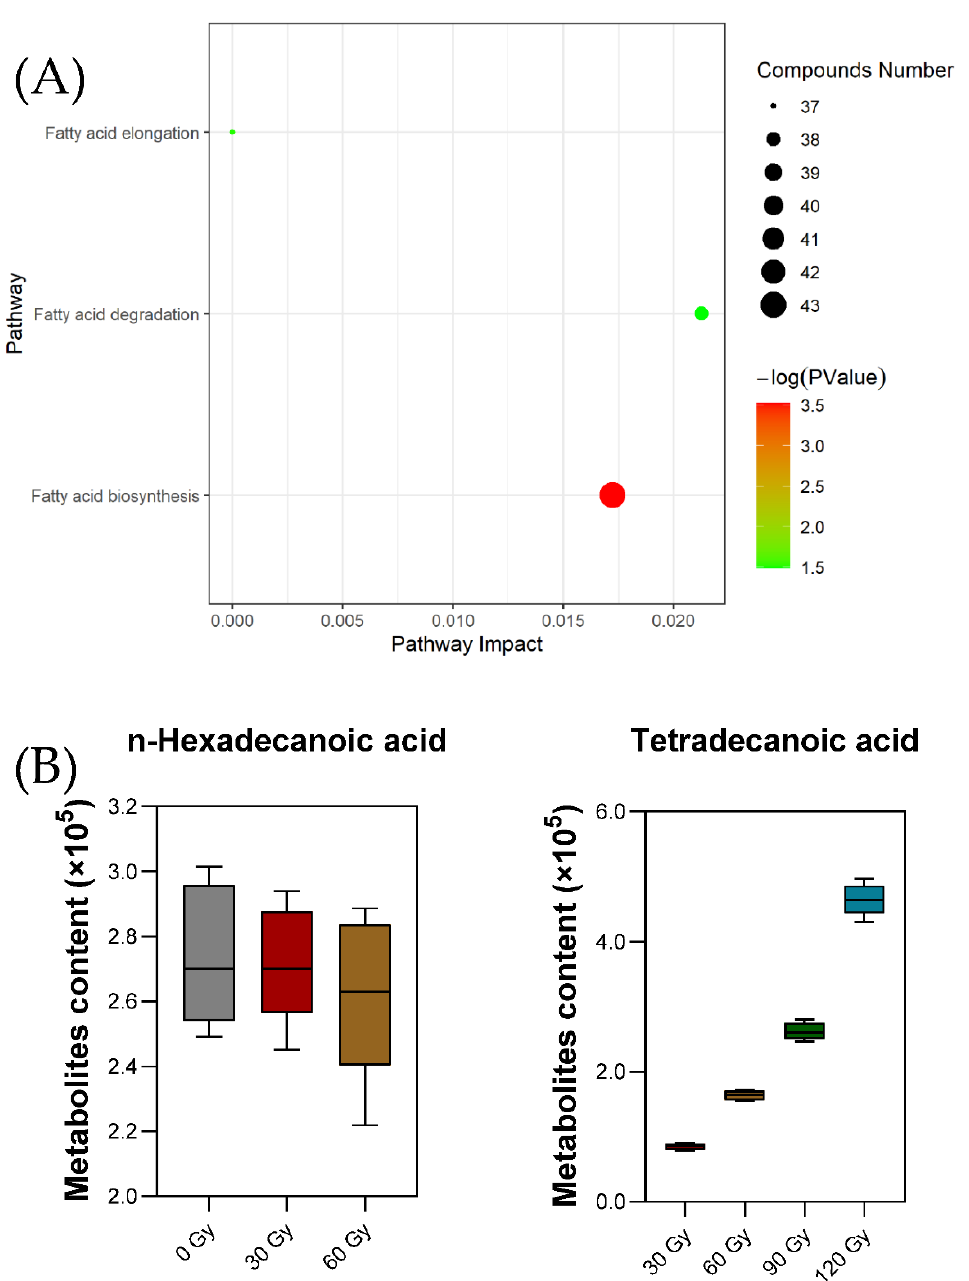
Figure 4. Effects of hit metabolites on metabolic pathways in B. dorsalis larvae ( A ). Content changes in metabolites in key metabolic pathways ( B ).